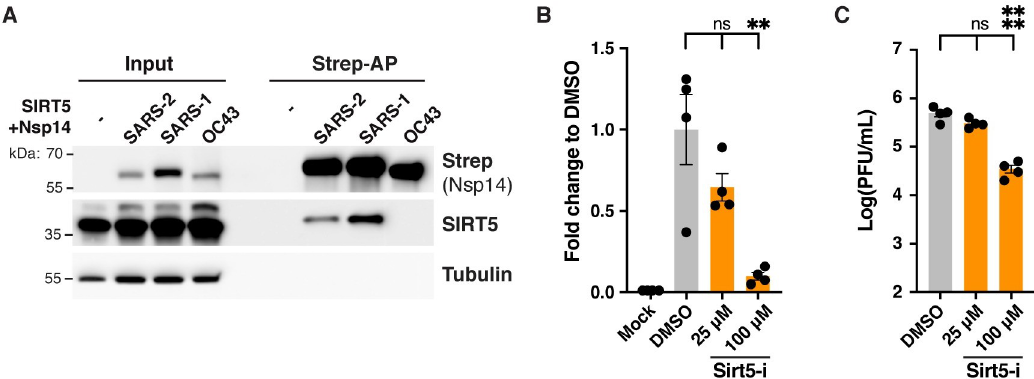
Fig 5. SIRT5 proviral activity is partially independent from the interaction with Nsp14. A. Strep-tag affinity-purification and western blot after transfection of SIRT5- KD HEK293T cells with SIRT5 and Nsp14-strep from different coronaviruses, showing that the interaction with SIRT5 is specific to SARS-like coronaviruses. B. Decrease in supernatant-associated viral mRNA levels in HCT-8 cells infected with HCoV-OC43 for 5 days at MOI = 0.1, and treated with SIRT5 inhibitor Sirt5-i, as shown by RT-qPCR. Data show fold-change compared to DMSO-treated levels. n = 4. C. Decrease in viral titers in HCT-8 cells infected with HCoV-OC43 for 5 days at MOI = 0.1, and treated with SIRT5 inhibitors Sirt5-i, as shown by plaque assay. n = 4. B-C. Data show mean and SEM between biological replicates. Asterisks summarize the results of one-way ANOVAs followed by Holm–Sˇida´k multiple comparisons test (on log-transformed data for plaque assays) � : p < 0.05, �� : p < 0.01, ��� : p < 0.001, ���� : p < 0.0001.